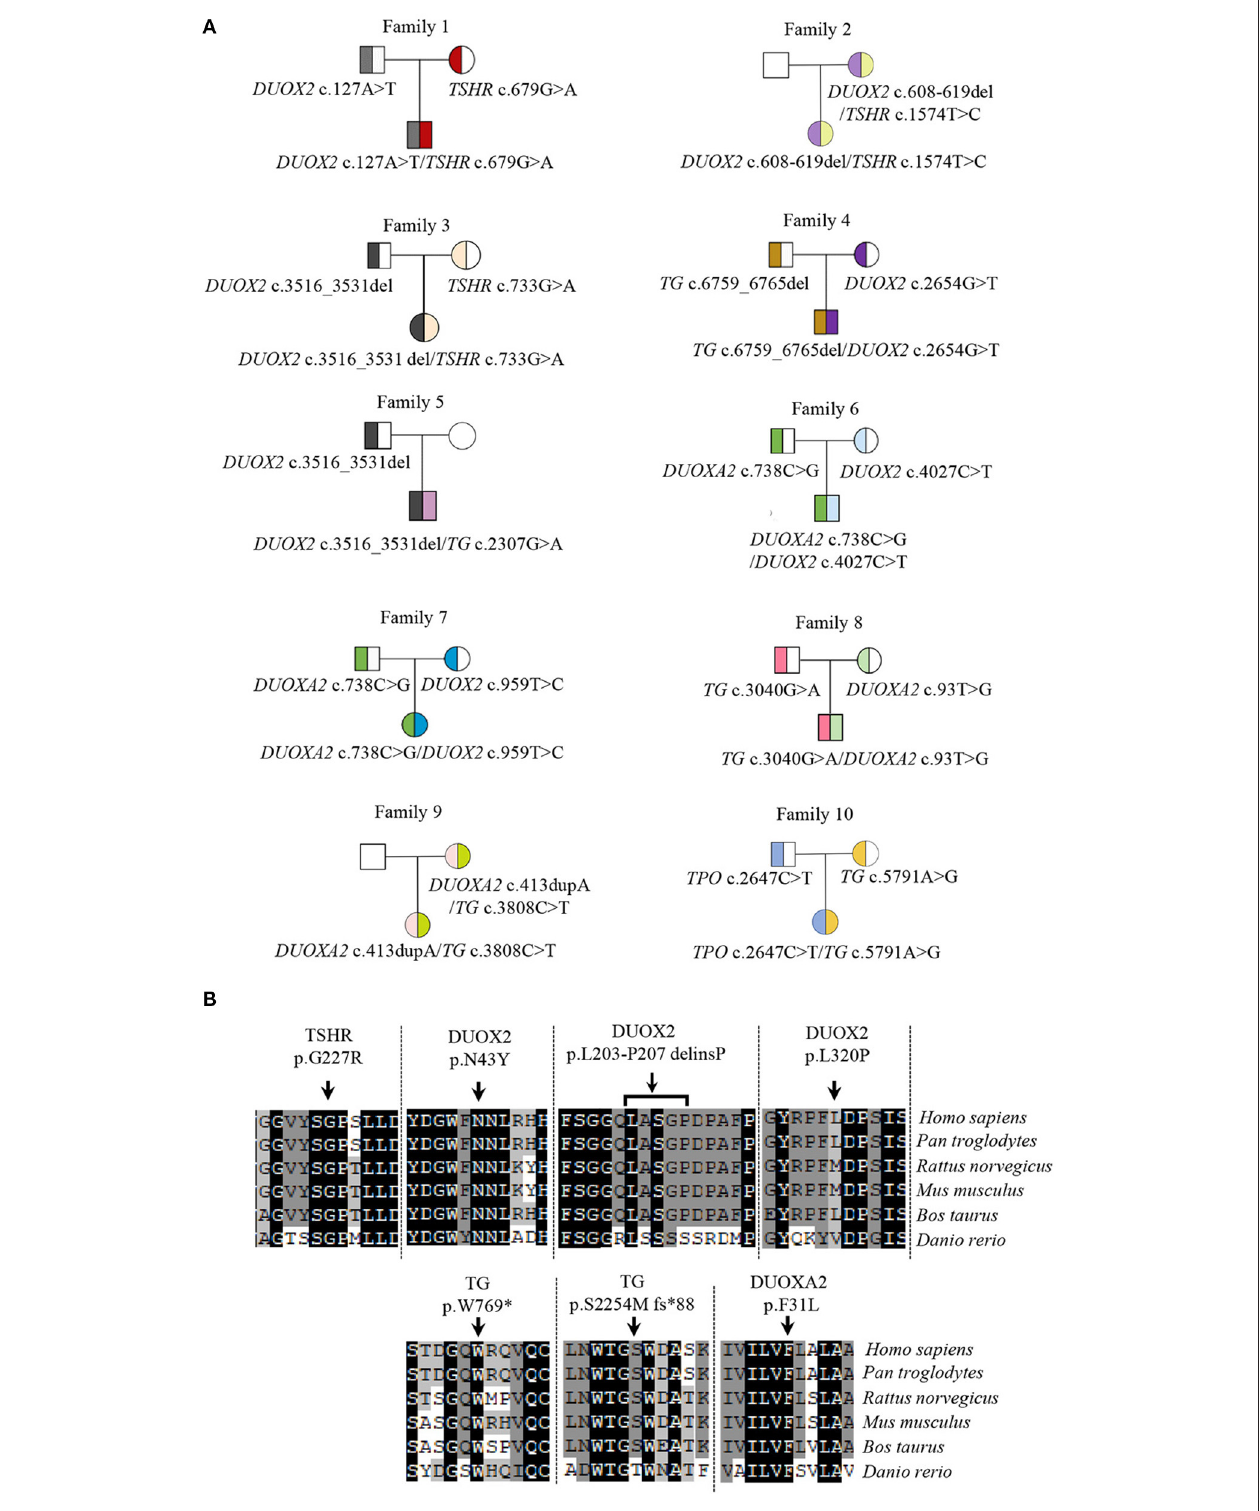
FIGURE 1 | Variants in CH patients and their conservative analysis. (A) Genotypes of CH pedigrees; (B) Conservative analysis of seven novel variants in species. The reference sequences for TSHR , DUOX2 , TG, and DUOXA2 in species are followed as: TSHR: Homo sapiens, NP_000360.2; Pan troglodytes,